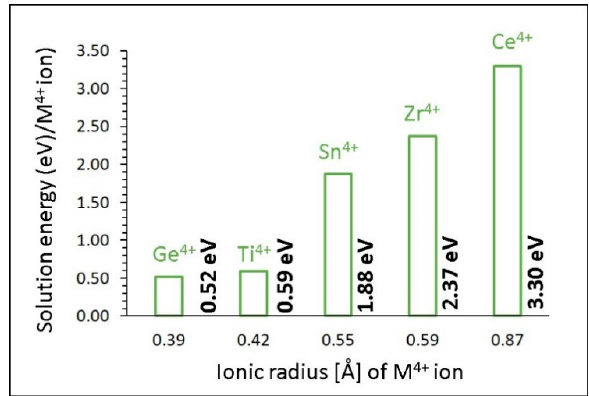
7 Figure 6. Solution energy of M 2 O 3 (M = Co, Mn, Ni, Mg, Zn, Sr and Ba) with respect to the M 3+ ionic radius. 3.4.3. Tetravalent Dopants Finally, tetravalent cations (Ge 4+, Ti 4+ , Sn 4+ , Zr 4+ and Ce 4+ ) were considered on the Si site. Solution energy was calculated using the following reaction equation. MO (cid:2870) + Si (cid:2903)(cid:2919) (cid:2908) → M (cid:2903)(cid:2919) (cid:2908) + SiO (cid:2870)